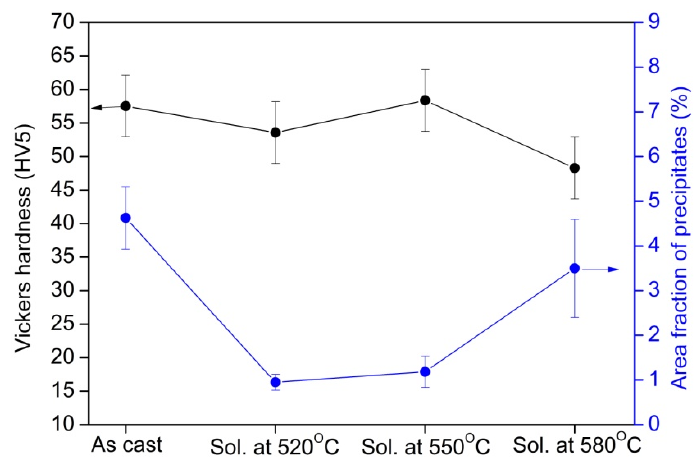
Figure 4. Vickers Hardness and area fractions of precipitates for as-cast El21 and solutionized samples at different solution treatment temperatures.